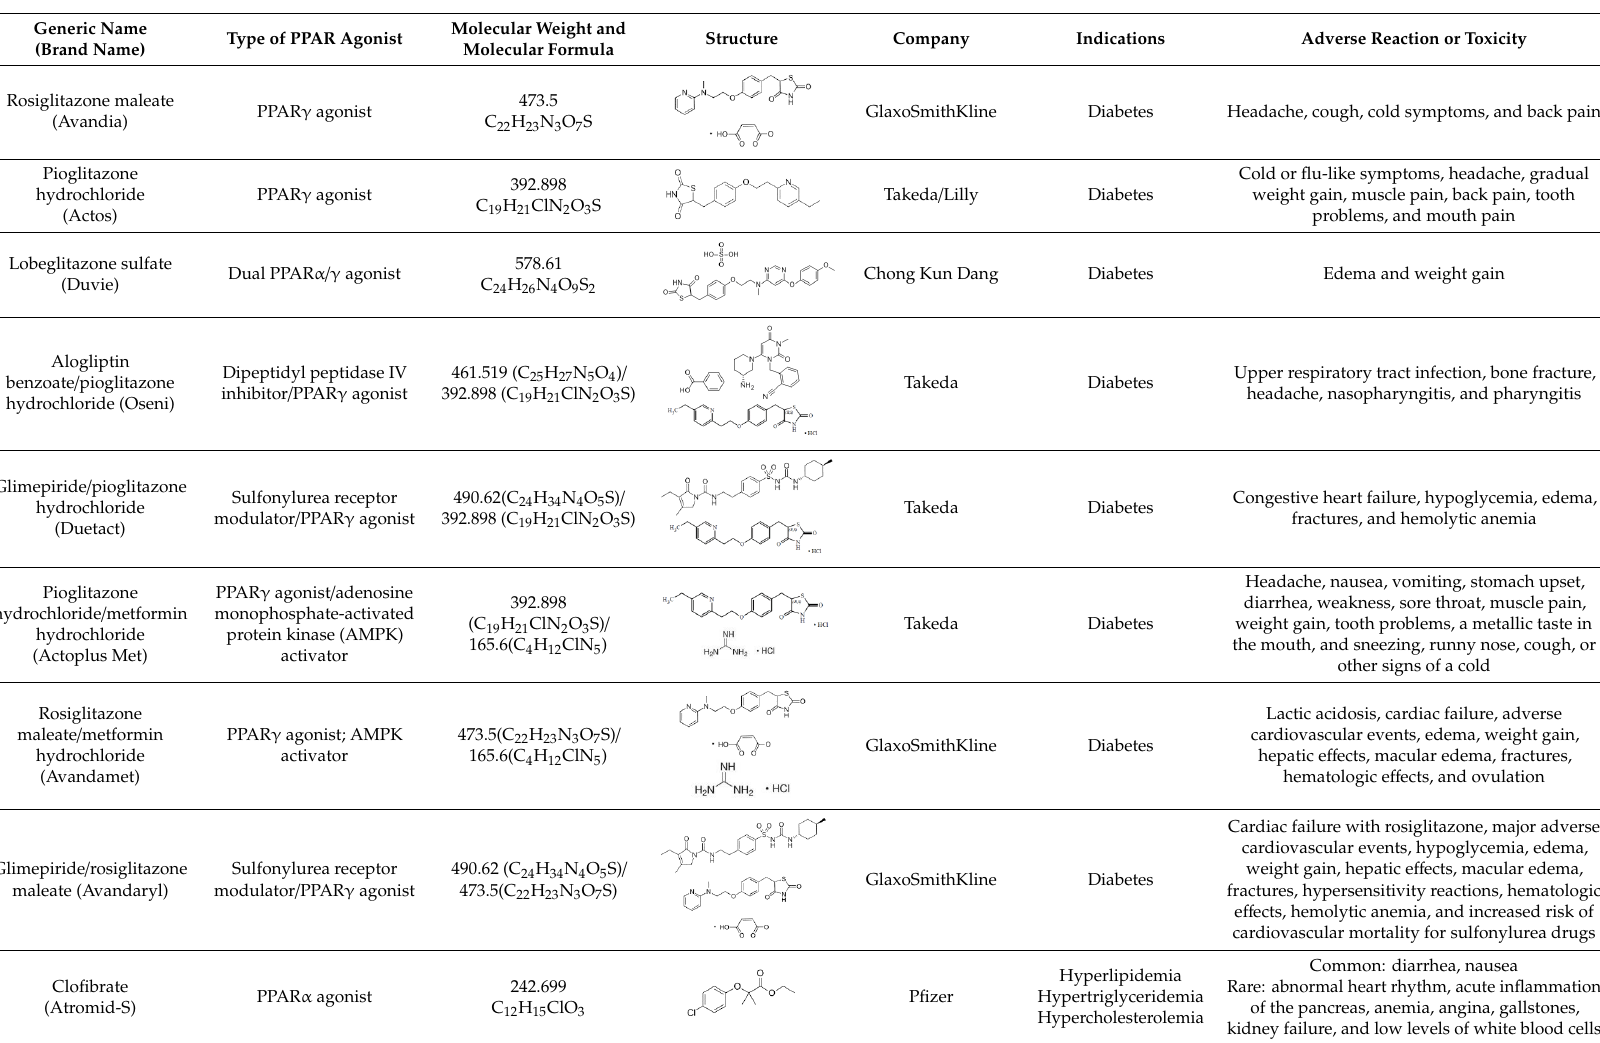
Table 1. The information and adverse reactions or toxicity of peroxisome proliferator-activated receptor (PPAR) targets related to 18 approved clinical drugs. Generic Name (Brand Name)